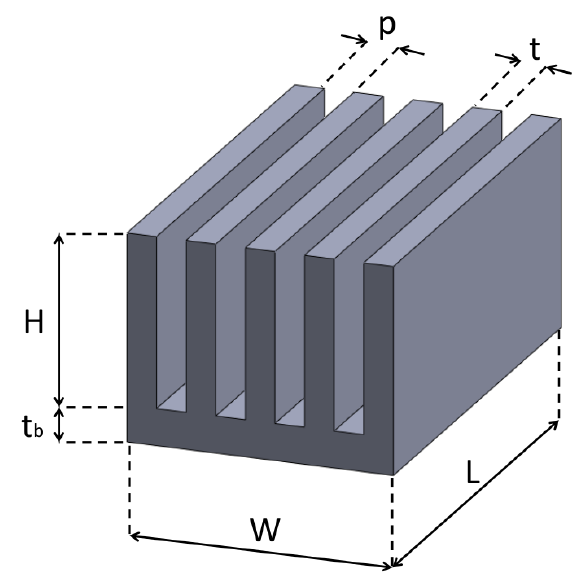
Figure 1. Heat sink